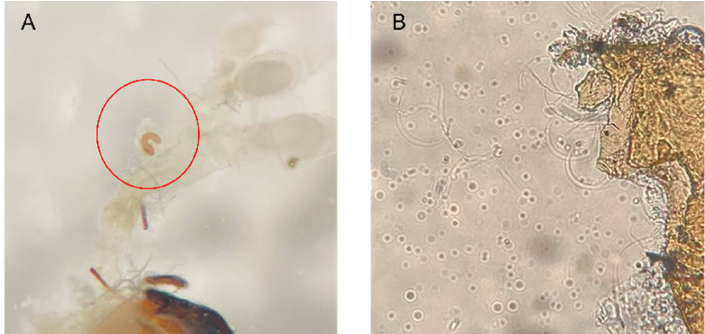
Figure 3. The sperm in spermatheca. ( A ) Spermatheca (shown in red circle) of females were dissected using fine forceps and observed with a microscope. ( B ) The observation of sperm in the spermatheca.